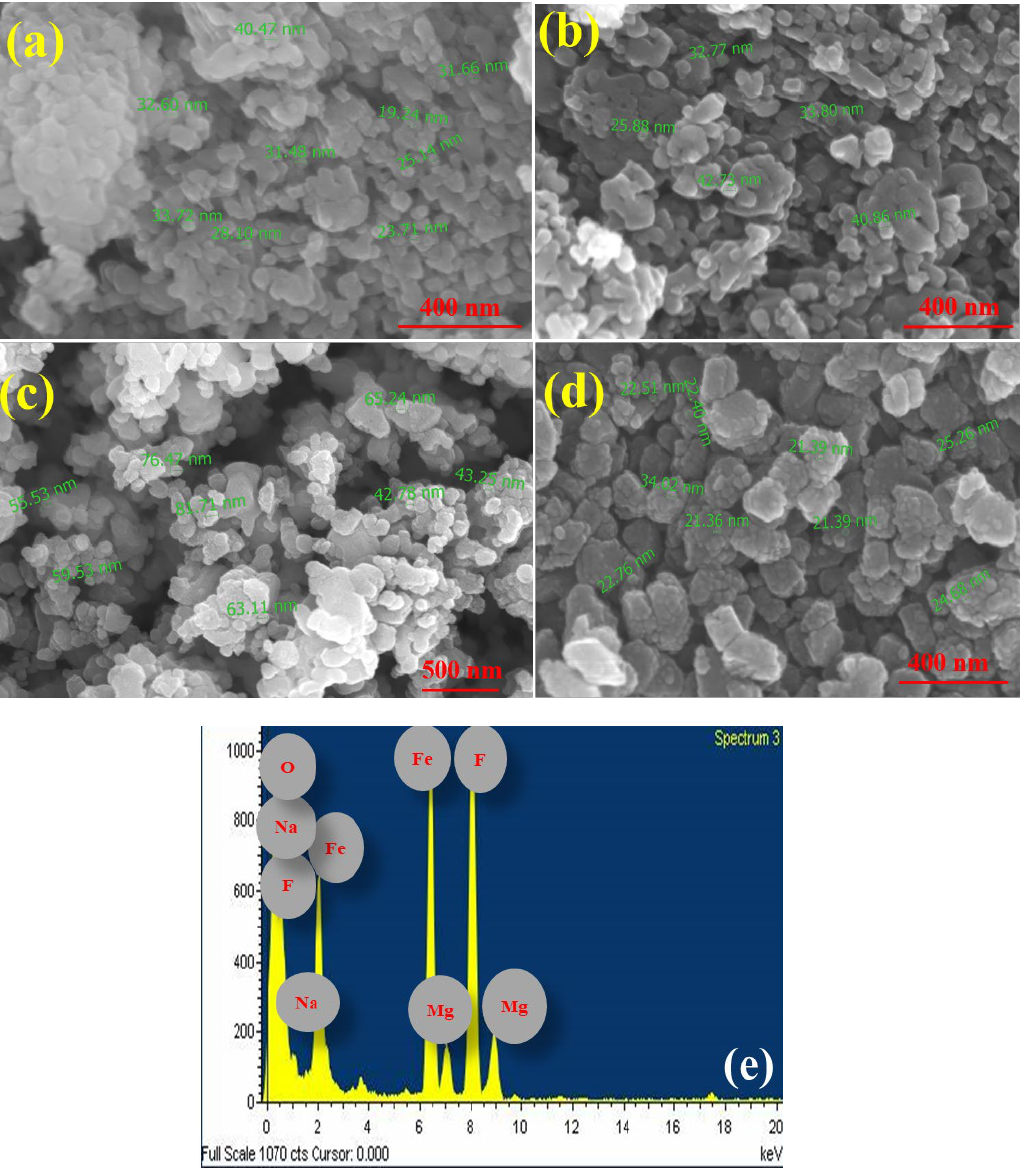
Figure 3. ( a – d ) FESEM images of NMFF1, NMFF2, NMFF3, and NMFF4. ( e ) EDS spectrum of